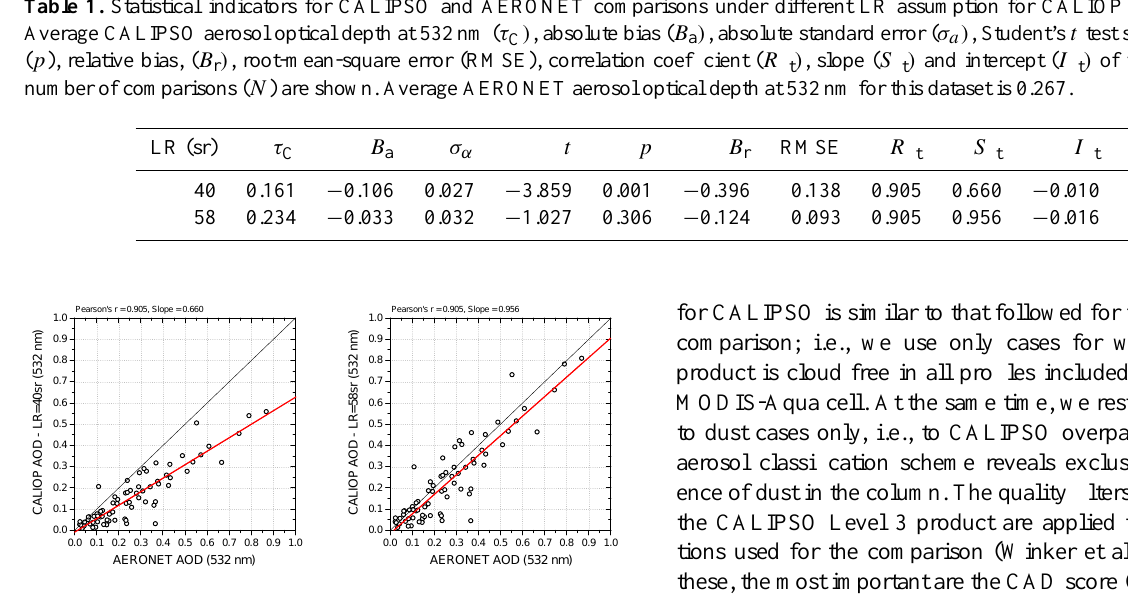
Fig. 2. Scatter plot comparison of CALIPSO AOD IntOfMean vs. col- located AERONET measurements when LR is equal to 40sr (left) and when LR is equal to 58sr